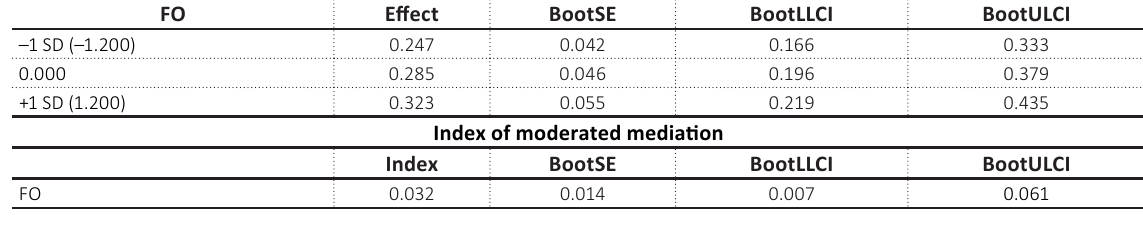
Future orientation